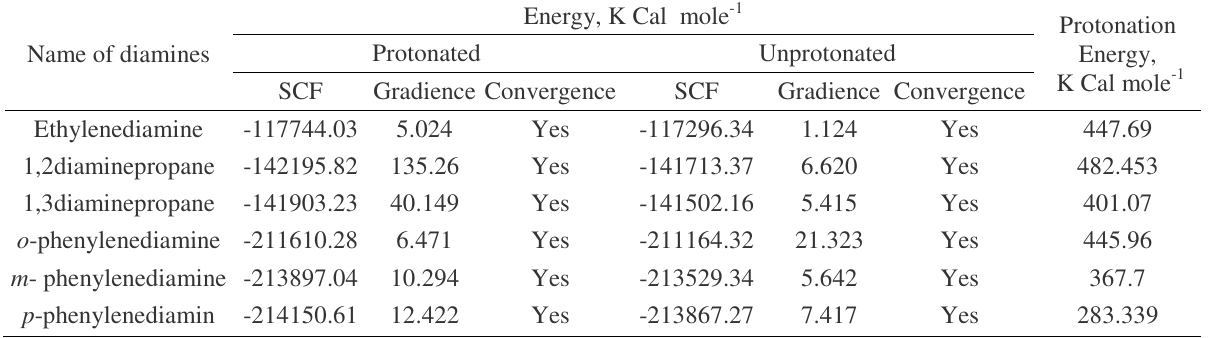
Table 2. Calculation of Protonation Energy and other Parameters in Various Diamine